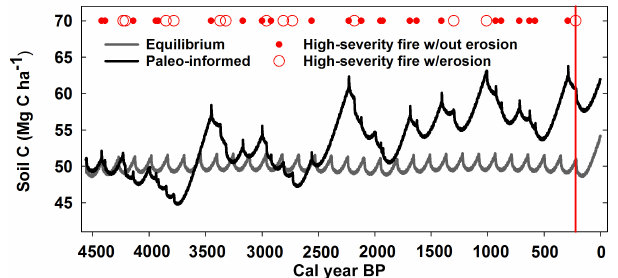
Figure 2. Model simulations of equilibrium (grey) and paleo- informed (black) total soil carbon (C) inMgCha − 1 . Each simu- lation branches from a 2000-year equilibrium spin-up starting at the same soil C baseline and runs for 4561 years (4500BP to 2010CE). The large open circles represent the years of the high-severity fires with erosion, and the small closed circles are high-severity fires without erosion used to drive the paleo-informed model run. A con- stant 145-year fire return interval was used for the equilibrium run. The vertical red line indicates the most recent stand-replacing fire (1782CE), reconstructed from the tree-ring record (Sibold et al.,